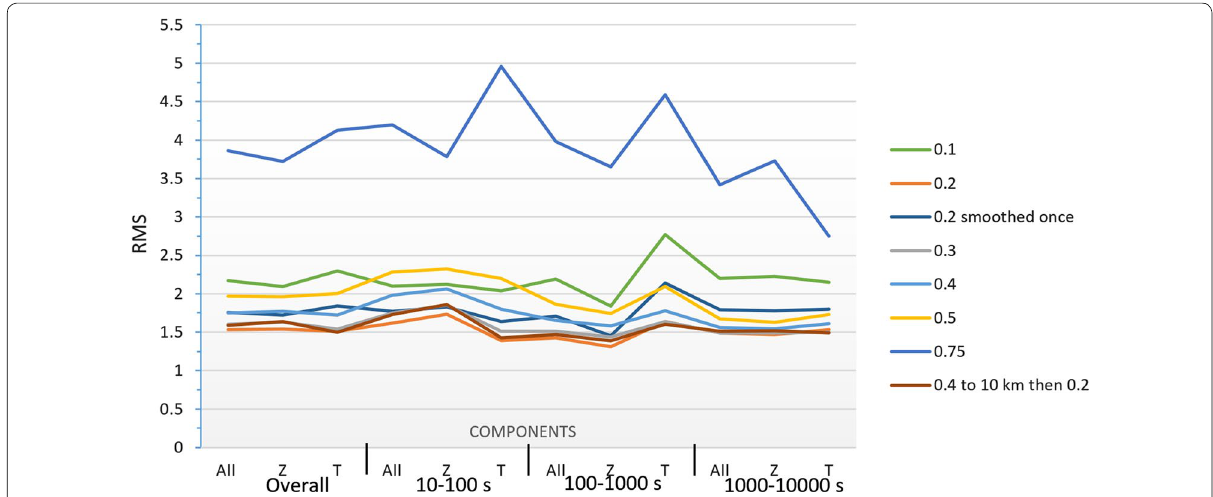
Fig. 14 Plot of covariance vs. RMS for the overall RMS, and for the period ranges of 10–100, 100–1000 and 1000–10,000